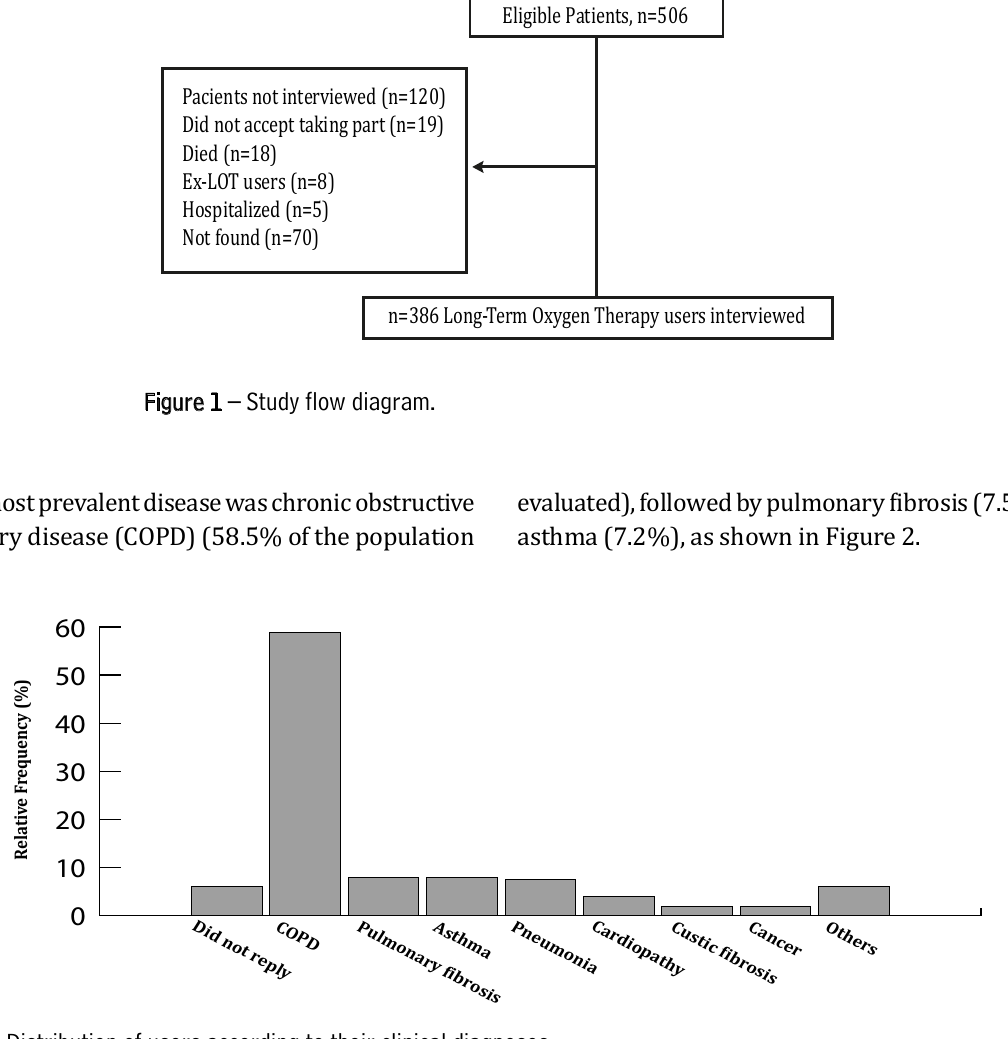
Figure 2 – Distribution of users according to their clinical